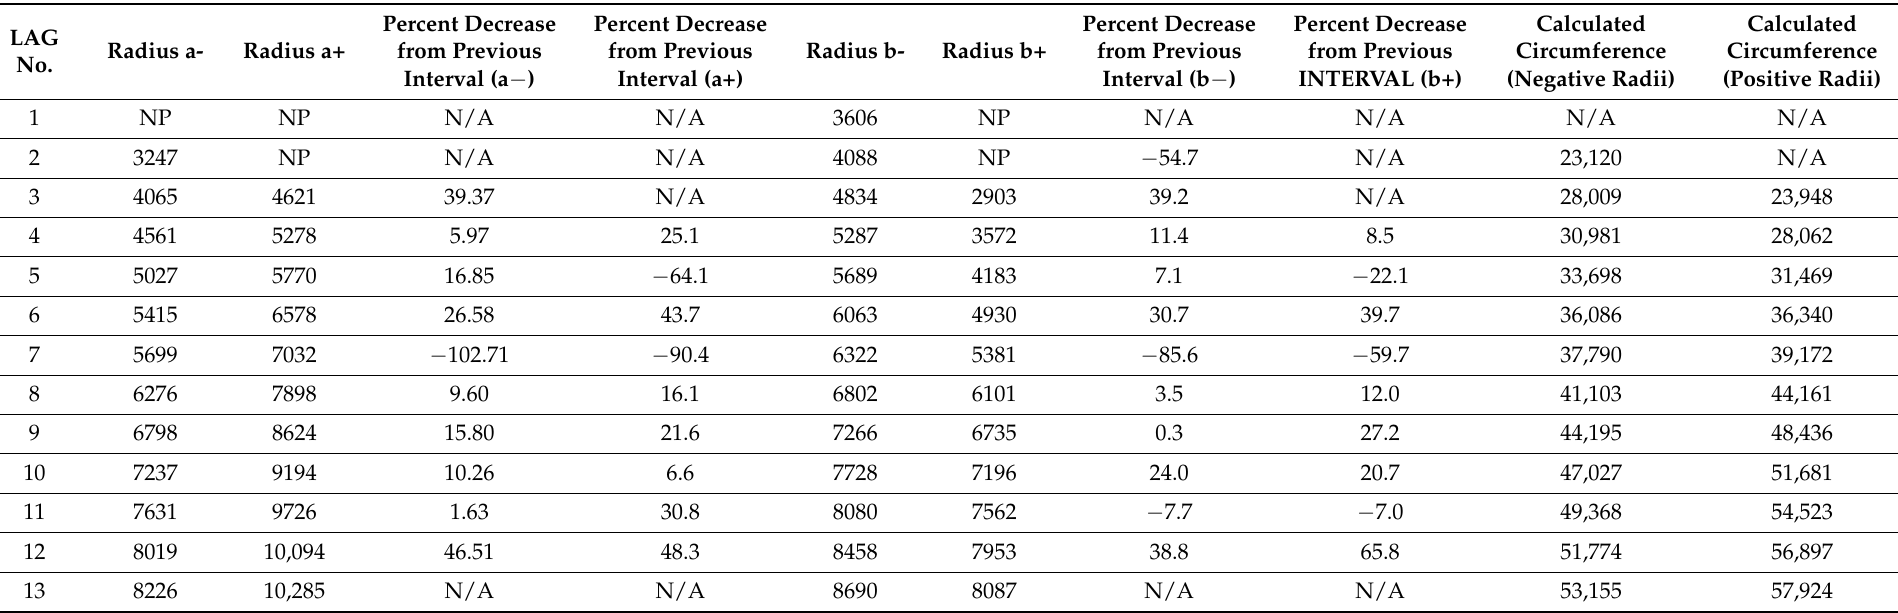
Table 1. Distance (in microns) from the centroid to each preserved line of arrested growth (LAG) in the right humerus of NJSM 23368 (slide 1, scan 1), in centrifugal order. Transverse diameters were determined by first measuring the widest point through the center of the bone section (establishing diameter a, the horizontal axis), and then identifying the greatest height at 90 ◦ to that line (diameter b, the vertical axis). The intersections of these diameters defined the centroid. Radius a+ is the axis to the right of the centroid, a- is to its left, b+ to its top, and b- to its bottom. N/A = Not Applicable; NP = Not